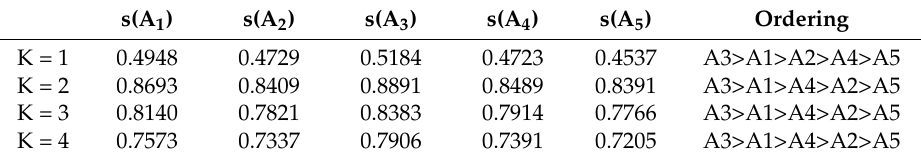
Table 6. Ranking results for different operational parameters of the IV2TLPFWGMSM operator.